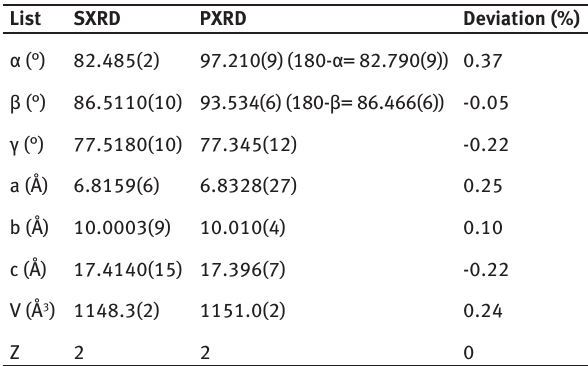
Table 1: Lattice parameters.